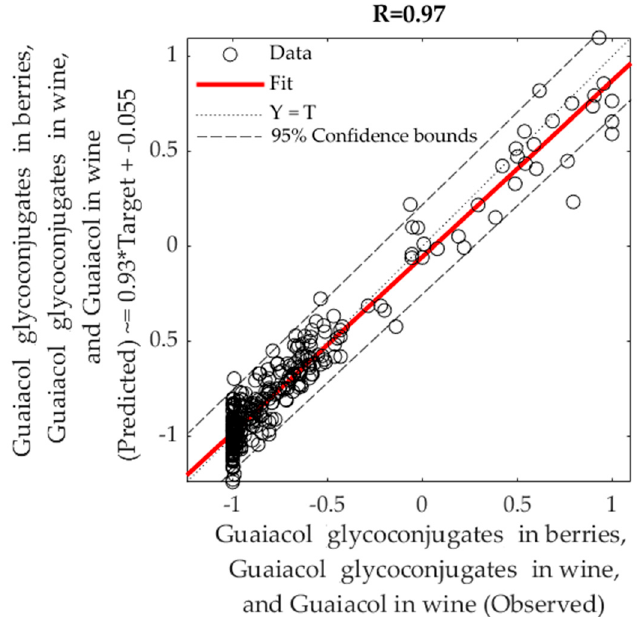
Figure 8. Overall fitting model using machine learning (Sequential Order Weights and Bias) using NIR spectra (700–1100 nm; second derivative transformation) of berries from seven grapevine cultivars as inputs and main smoke taint compounds found in berries and wine as targets.